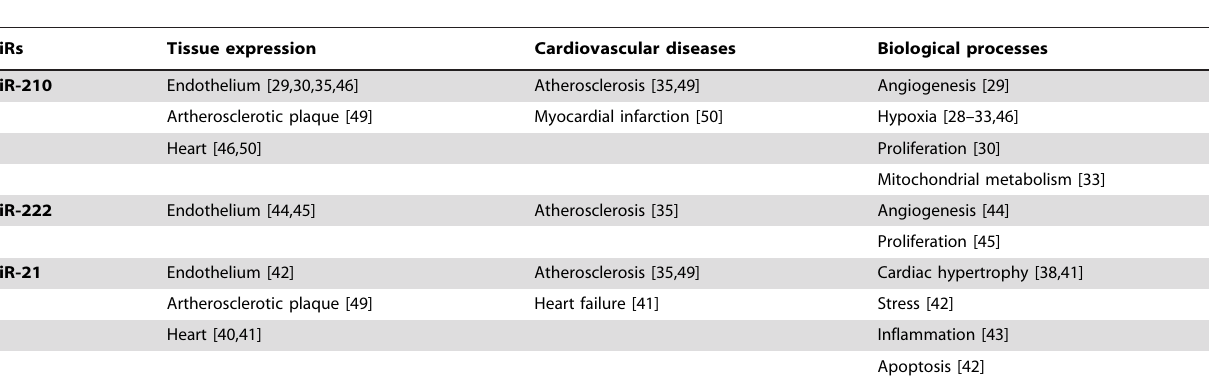
Table 2. Tissue of expression, associated cardiovascular diseases and biological processes linked to the differentially expressed microRNAs in this study.